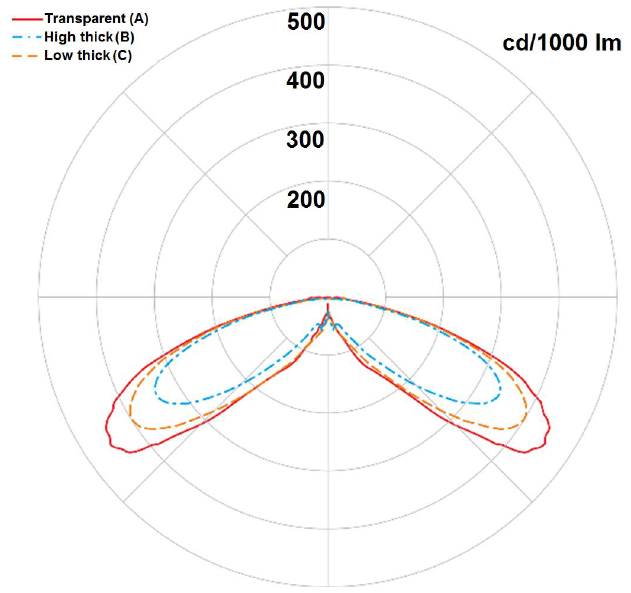
Figure 4. Comparative Photometric diagram of the C0–C180 planes for the test lamp with the 3 covers tested. Energies 2018 , 11 , x 10 of 16